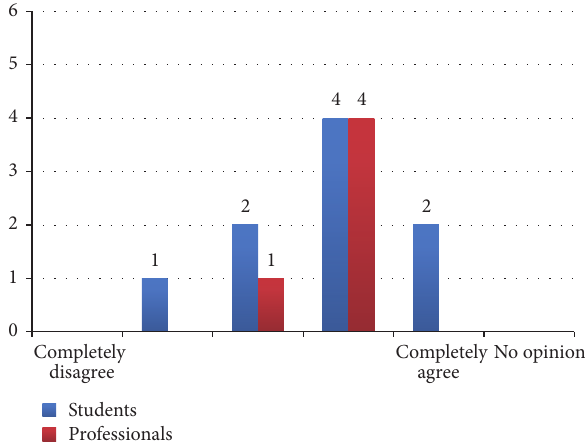
Figure 8: Statement: I have great confidence in the result of ECW/PUEA.